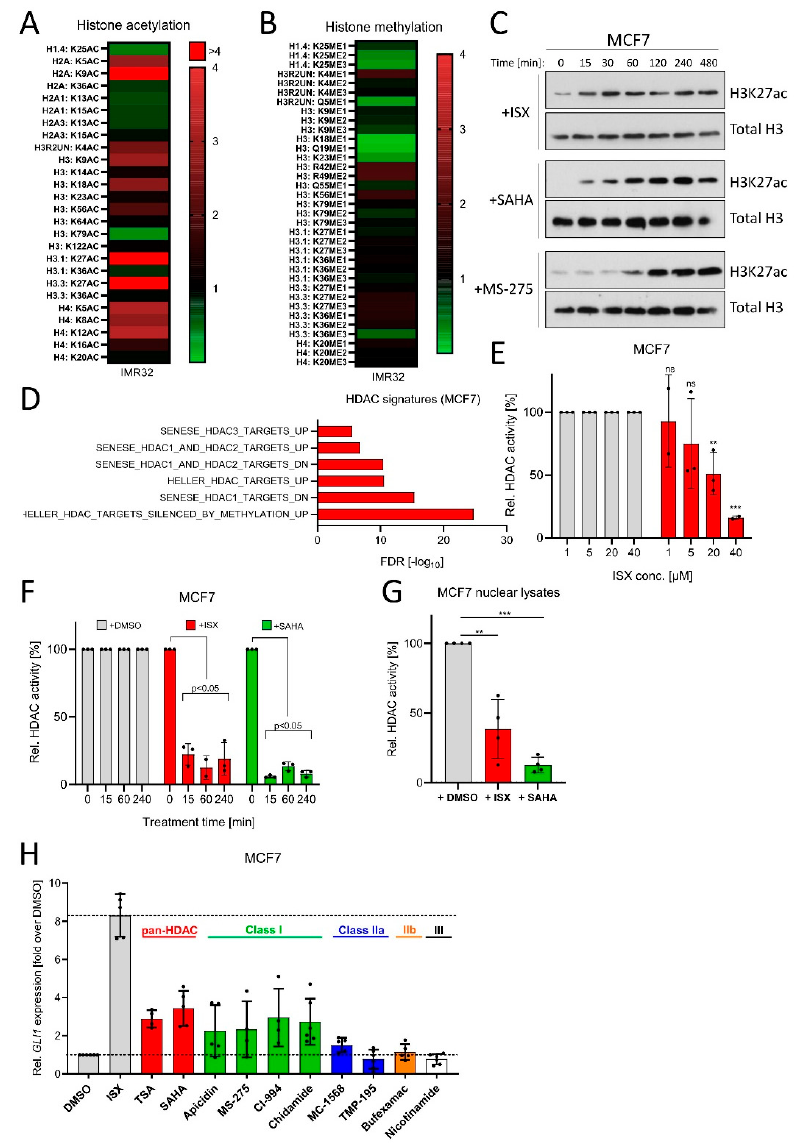
Figure 6. ISX possesses HDAC inhibitory functions. ( A ) Mass spectrometric determination of acetylated histone residues in IMR32 cells. Treatment with ISX (20 µM) for 8 h. ( B ) Mass spectrometric determination of methylated histone residues in IMR32 cells. Treatment with ISX (20 µM) for 8 h. ( C ) Western blot analysis of H3K27 acetylation kinetics in MCF7 cells treated with ISX (20 µM), SAHA (1 µM) or MS-275 (1 µM). Total histone H3 levels were used as normalizing control. Shown is one representative of n = 3 experiments. ( D ) HDAC-related transcriptome signatures (RNAseq) of ISX (20 µM, 48 h)-treated MCF7 cells versus DMSO control. ( E ) Cellular HDAC class I/II activity in MCF7 cells exposed to the indicated concentrations of ISX for 1 h. Shown is one experiment measured in duplicate/triplicate (mean ± SD). DMSO controls were set to 100%. ( F ) Cellular HDAC class I/II activity in MCF7 cells exposed to 20 µM ISX (or 5 µM SAHA) for the indicated times. Shown is one experiment measured in duplicate/triplicate (mean ± SD). DMSO controls were set to 100%. ( G ) Class I/II HDAC activity in isolated and lysed MCF7 nuclei, which were treated in vitro (10 min, RT) with DMSO (set to 100%), 20 µM ISX or 5 µM SAHA. Shown is one of n = 2 experiments measured in quadruplicate (mean ± SD). ( H ) GLI1 expression in MCF7 cells treated for 24 h with the indicated compounds. ISX: 20 µM; TSA: 0.5 µM; SAHA: 0.5 µM; Apicidin: 0.25 µM; MS-275: 1 µM; CI-994: 10 µM; Chidamide: 5 µM; MC-1568: 5 µM; TMP-195: 1 µM; Bufexamac: 50 µM; Nicotinamide: 10 mM. Mean of at least n = 4 ± SD. Significances were indicated as ns (not significant; p > 0.05), ** p < 0.01, *** p < 0.001.